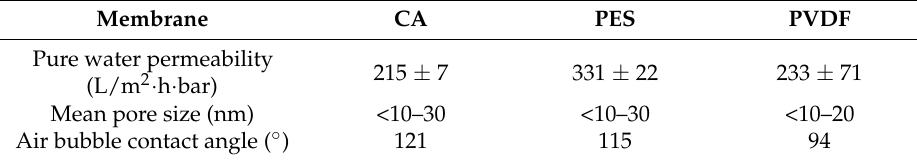
Table 3. Properties of CA, PES, and PVDF hollow fiber membranes.